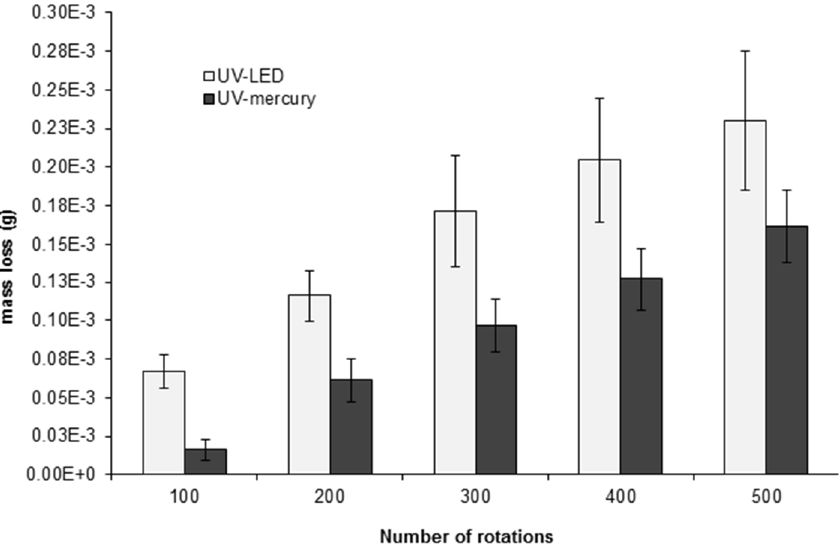
Figure 4. Graph of the mass loss in function of the number of